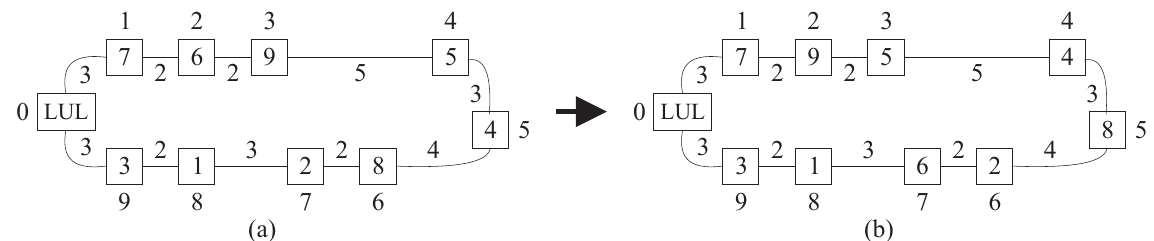
Figure 3. Moving machine r = 6 clockwise from location k = 2 to location l = 8 (or 9): ( a ) initial solution; ( b ) solution at the q th step where q =